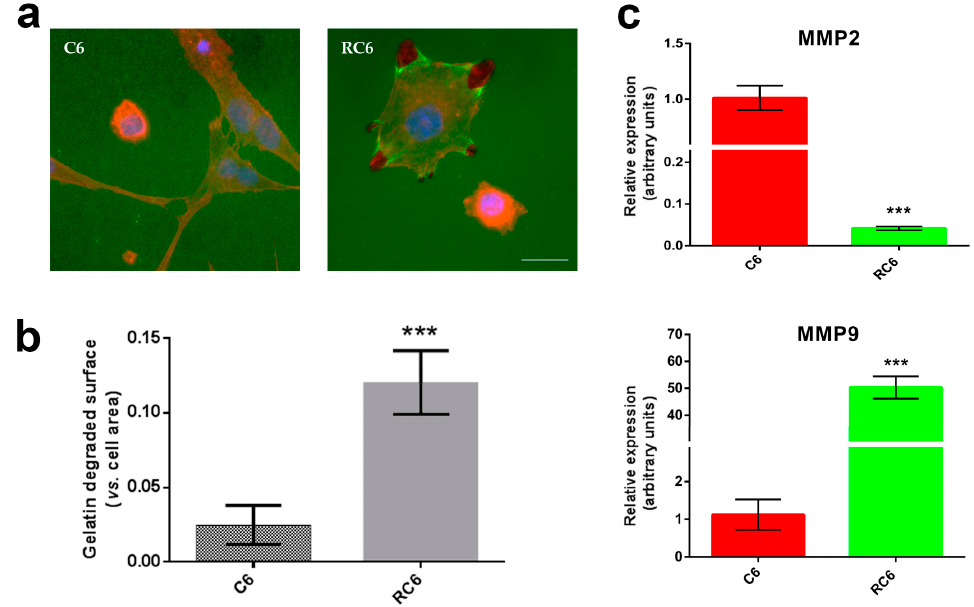
Figure 2. Gelatin degradation activity of C6 and RC6 cells. ( a ) Cells were plated on Oregon Green ® 488 Conjugate Gelatin for 24 h and afterwards stained with Hoechst 33342 ( blue ) and ActinRed 555. Areas of gelatin degradation appear as dark spots in the fluorescent background beneath the cells. Scale bar = 200 μ m; ( b ) Quantification of degraded surface of Oregon Green ® 488 Conjugate Gelatin per total area of cells. The average ± SEM obtained from three independent experiments ( n = 3) are presented. Statistical significance is shown as p < 0.001 (***); ( c ) Real-time qRT-PCR analysis was applied to assess MMP2 and MMP9 mRNA expression. As an internal control, β -actin mRNA expression was used ( n = 3). Statistical significance is presented as p < 0.001 (***).